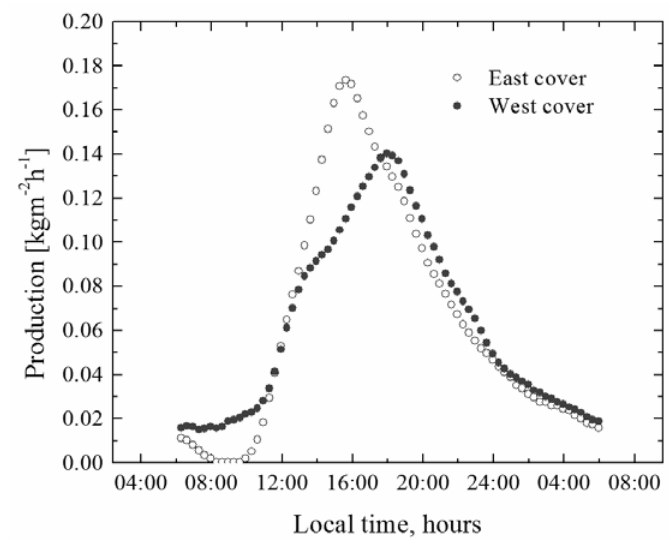
Figure 11. Distillate production with condensers facing an east–west direction in a double-slope condenser solar still (Reprinted from [19], with permission from Elsevier, 2019).